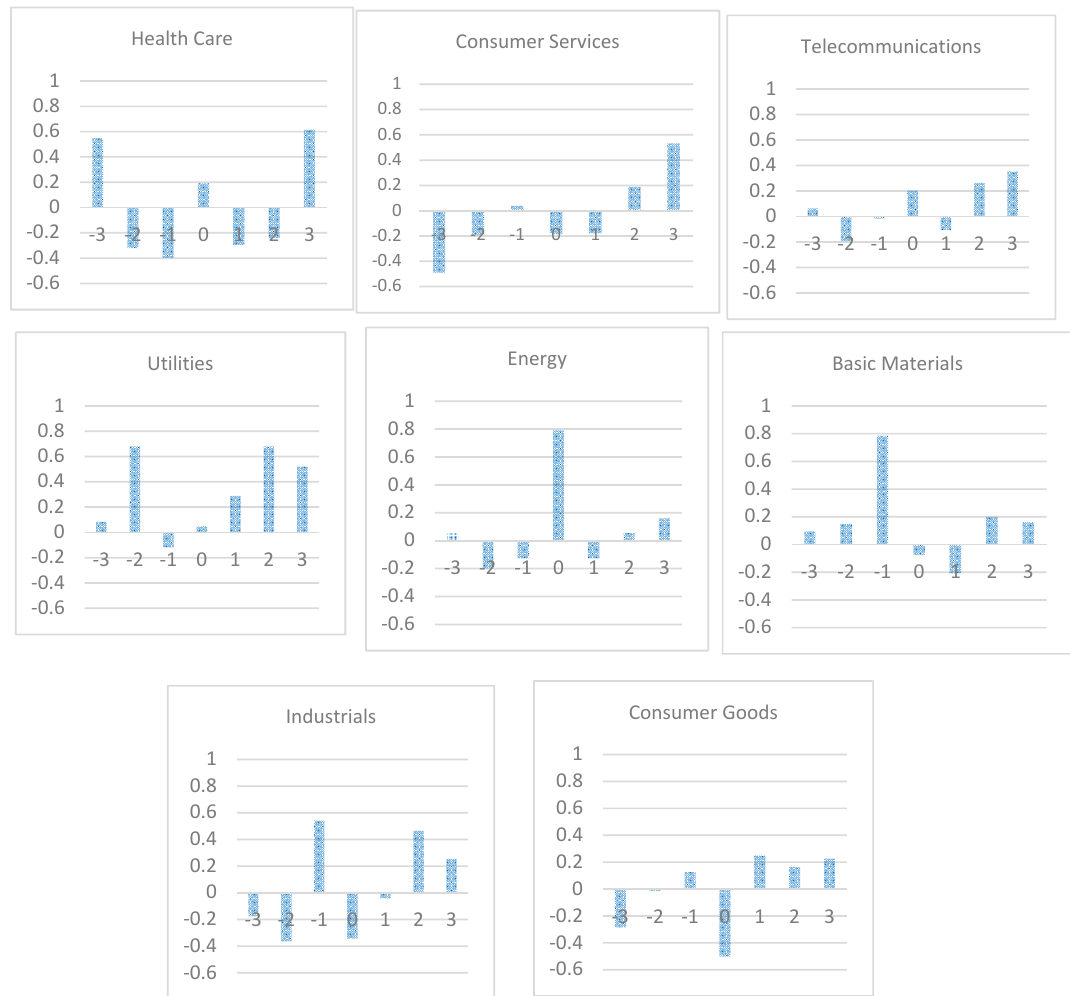
Figure 4. Cross correlograms for leads and lags of industry cash flows.